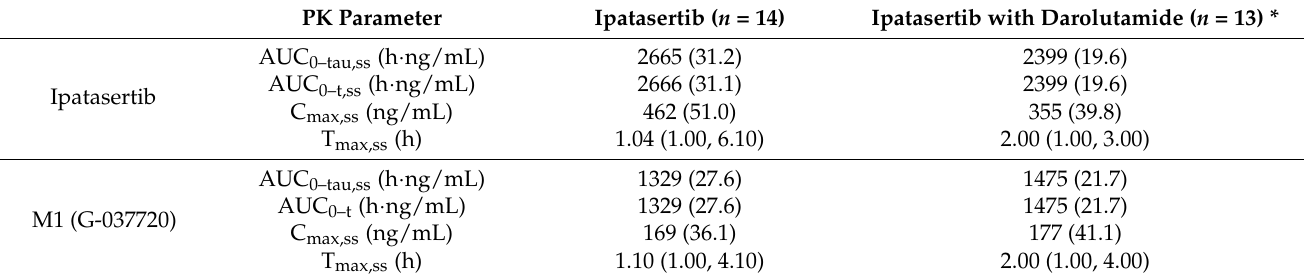
Table 2. Summary of ipatasertib and M1 (G-037720) pharmacokinetics following multiple-dose administration of ipatasertib 400 mg QD alone and in combination with darolutamide 600 mg BID. PK Parameter Ipatasertib ( n = 14) Ipatasertib with Darolutamide ( n = 13) *